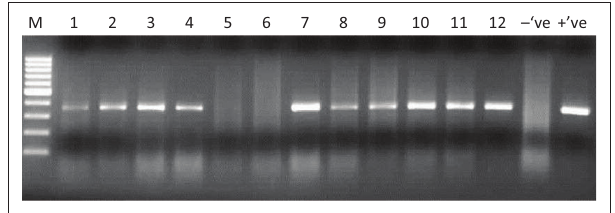
FIGURE 1: Positive reverse transcriptase–polymerase chain reaction of the peste-des-petits-ruminants virus N-gene of swab/homogenate samples is indicated by a 350-bp